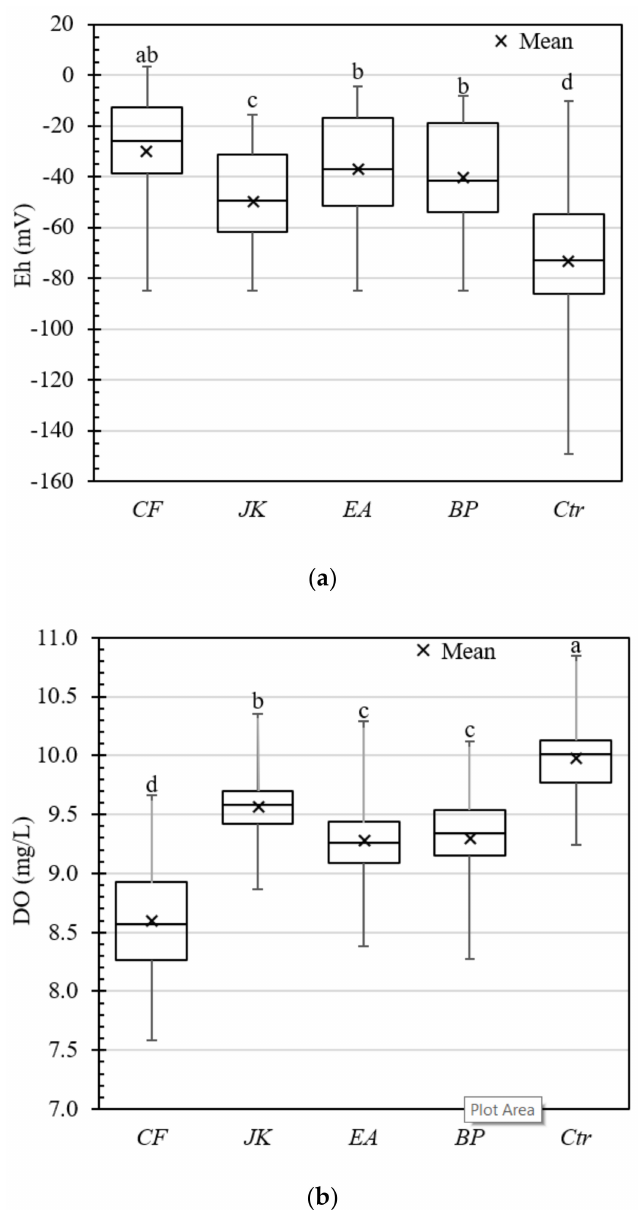
Figure 5. ( a ) Redox Potential, ( b ) Dissolved oxygen. Whisker-Box plots of Redox Potential (Eh) and Dissolved Oxygen (DO) for different treatments. One–way ANOVA with Duncan post-hoc analysis was performed for both Eh and DO. Values sharing a common letter label are not statistically